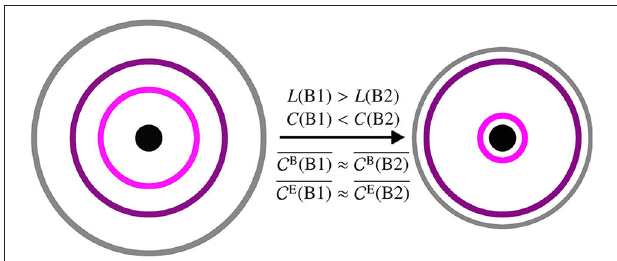
FIGURE 4 | Schematic of a spatial network prior to stimulation (phase B1, left ) and after stimulation (phase B2, right ). The network is separated into different areas based on global clustering coefficient C and average shortest path length L : boundary (gray outermost ring), periphery (purple and pink rings in the middle), core (black innermost ring/circle). The larger the radius of a ring the higher the average shortest path length and the smaller the average clustering coefficient of vertices in this area. The closer two rings the more clustered are the vertices in the two areas relative to each other. Averaged centralities ( C B and C E ) are not affected by the